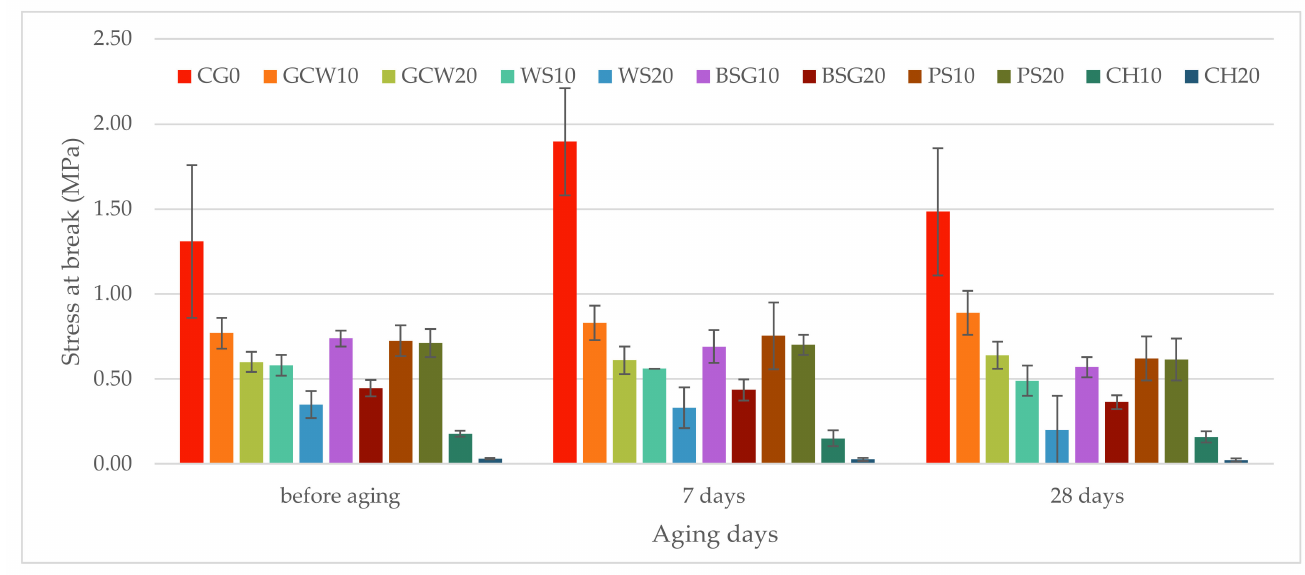
Figure 9. Materials’ stress at break (MPa).